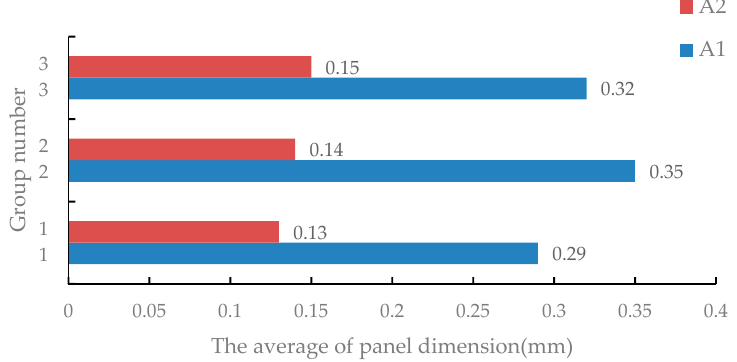
Figure 2. Effect of sanding thickness of RSP on panel dimension.